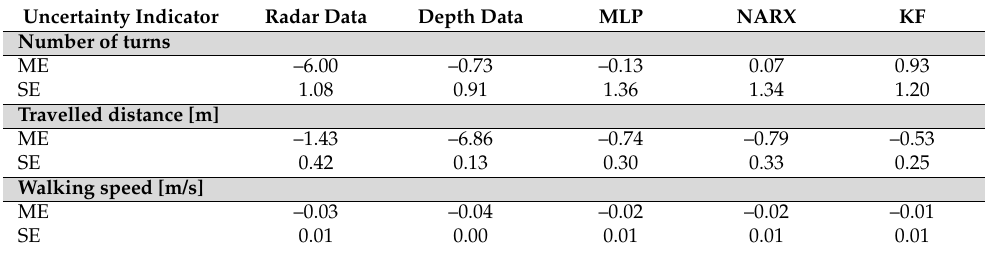
Table 3. Values of the uncertainty indicators obtained in